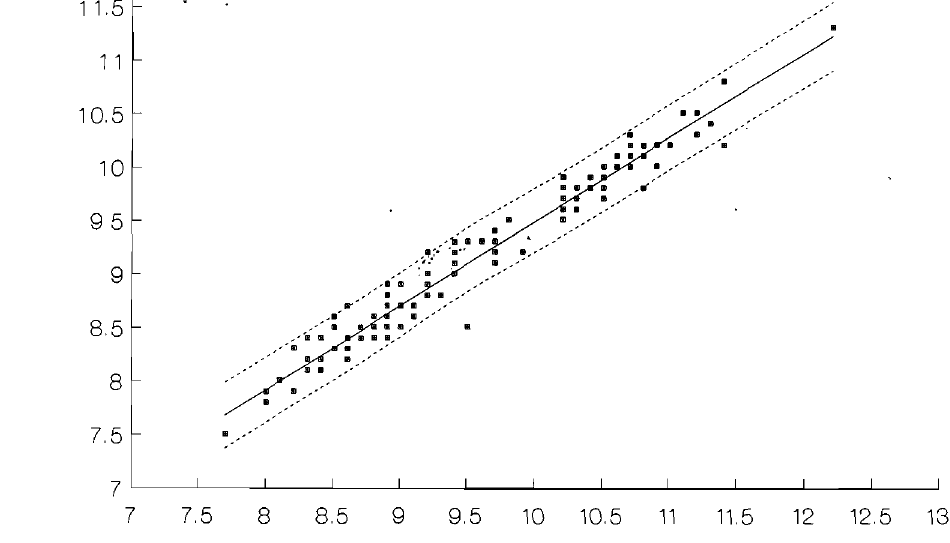
Fig. 1: Scatter-plot of the relationship between dissected transverse diameter (y) and the radiographically estimated transverse diameter (x), with the overall regression line for all ewes (- y = 1,63 + 0,786x; r = 0,98) and 95% con fidence limits for individual y-estimates (---). x-axis: Estimated transverse diameter (cm)